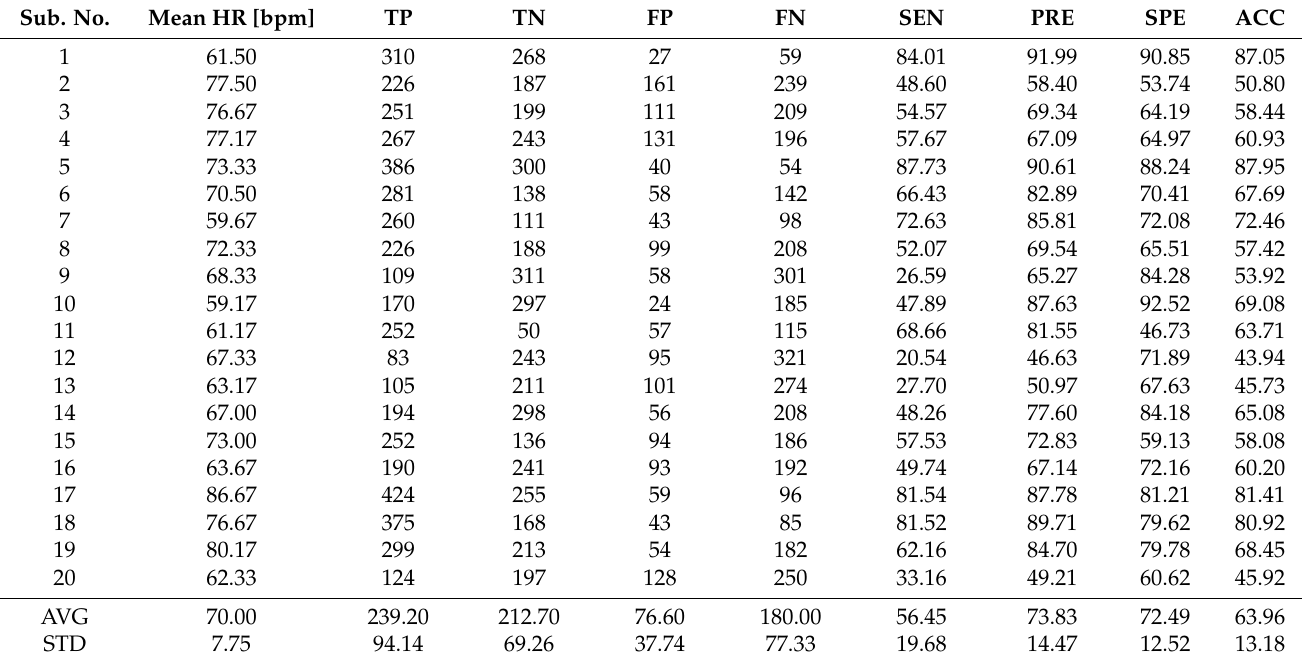
Table 4. Performance of the S2 peak detection in Model